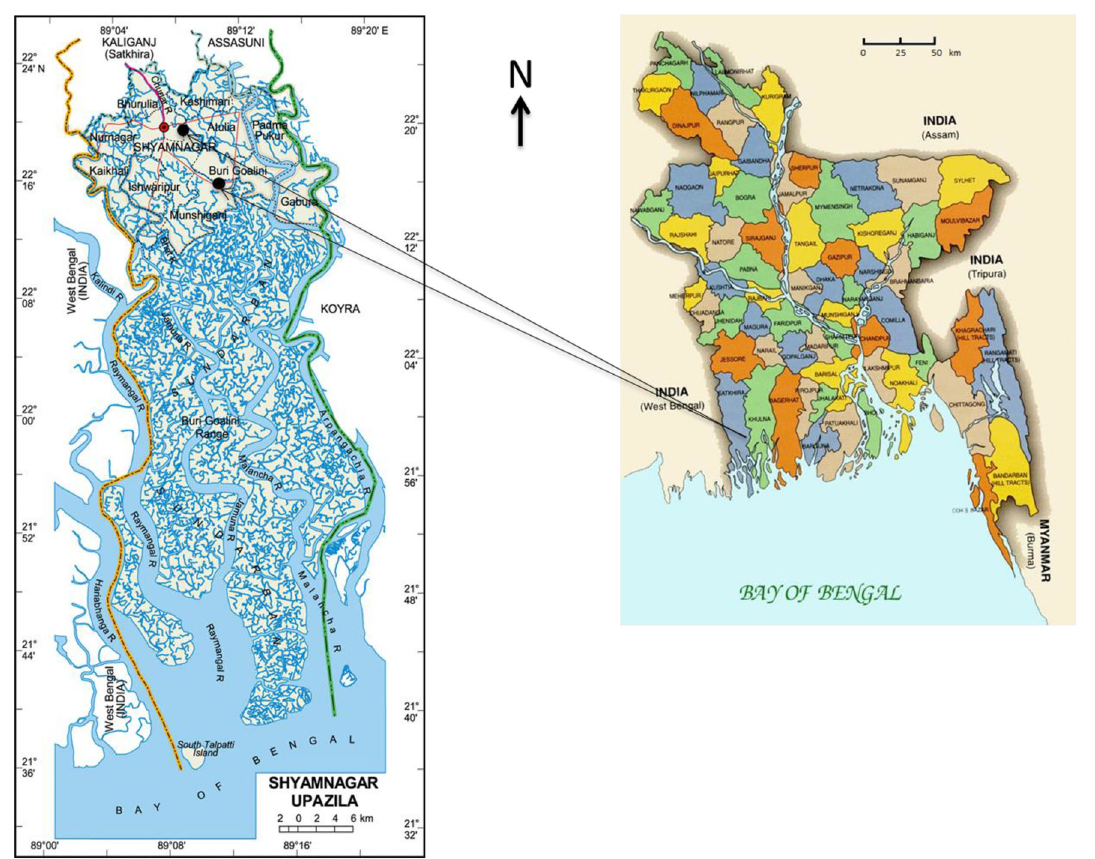
Fig. 1 Study area location in southwestern coastal Bangladesh: Durgabati and Gopalpur villages (black dots) in Shyamnagar upazila (subdistrict) of Satkhira District. Source : The Bangladesh country map is adapted from